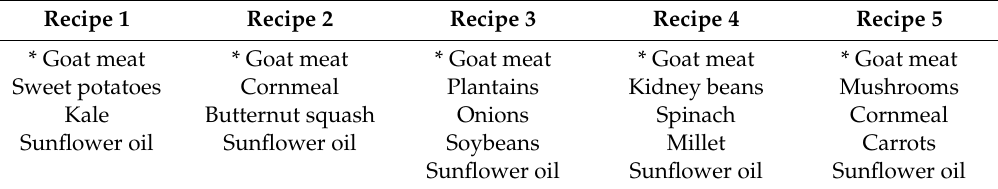
Table 6. Food components of the developed